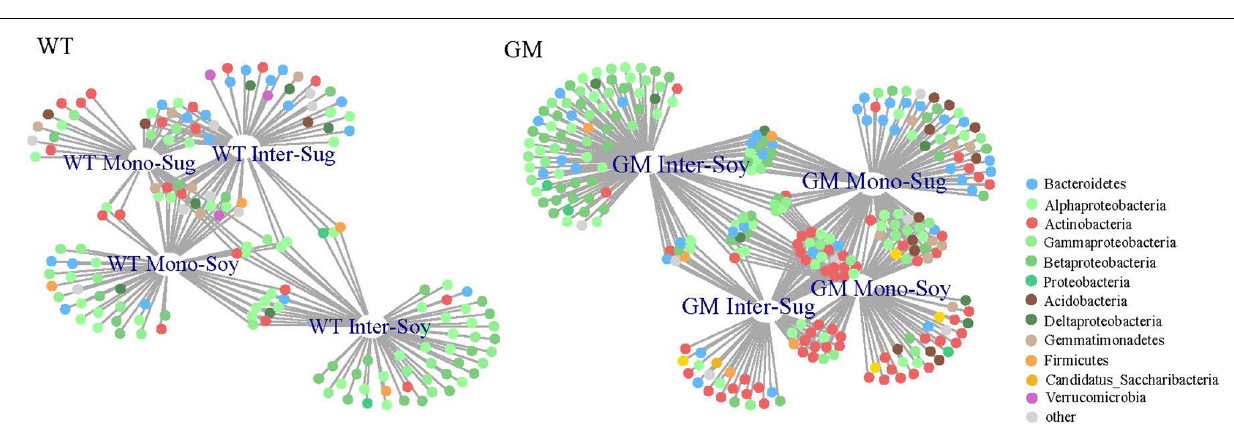
FIGURE 5 | Bipartite networks in the rhizosphere bacterial community shows the specific planting system OTUs. The circles represented single bacterial OTU, which were positively and significantly associated with one or more cropping methods ( P < 0.05). Different colors represent different phyla to which they